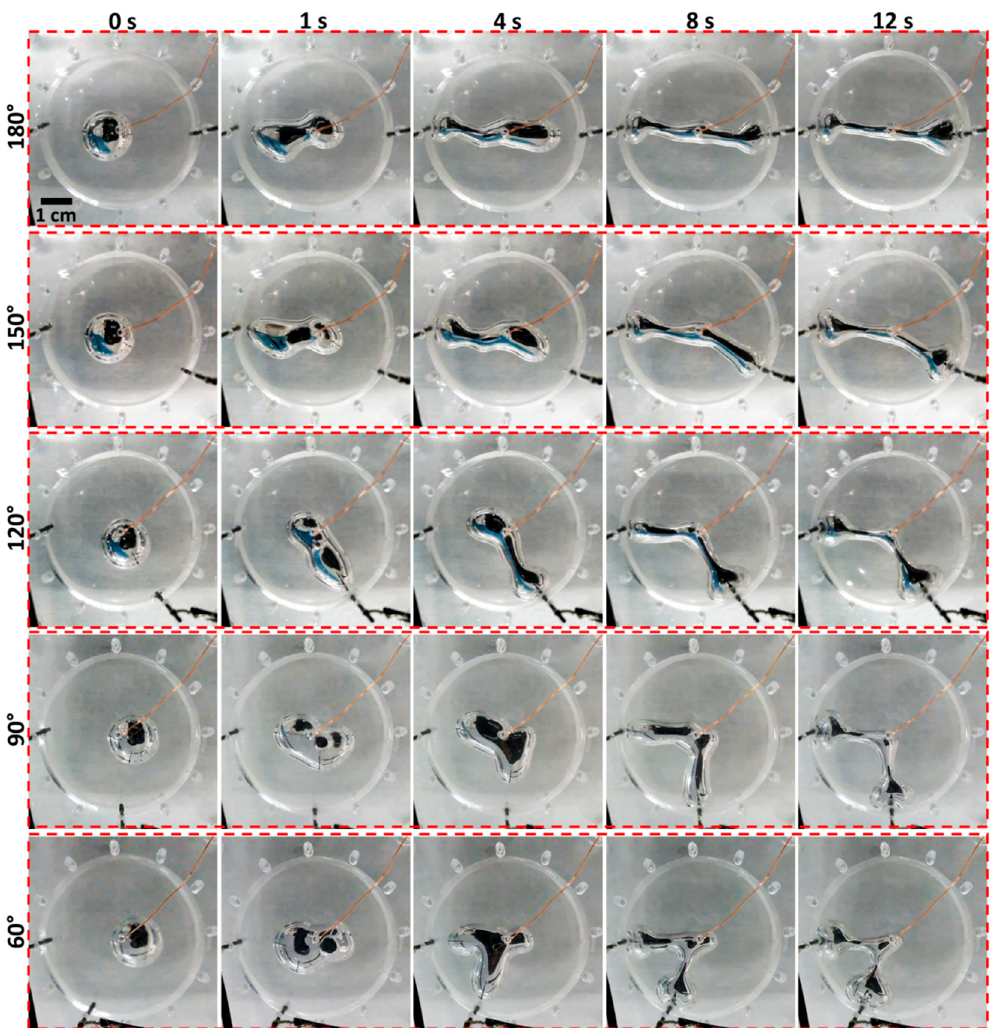
Figure 2. Automatic control of the morphology of the EGaIn droplet to five desired patterns (angles of protrusions are 180°, 150°, 120°, 90° and 60° from top to bottom) within 12 seconds after activating the control system. A series of snapshot images captured at 0, 1, 4, 8 and 12 s are shown for each pattern.